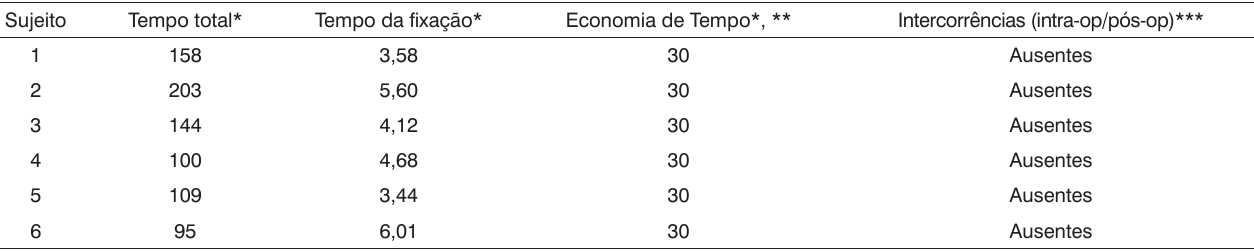
Tabela 4. Dados cirúrgicos dos pacientes implantados.